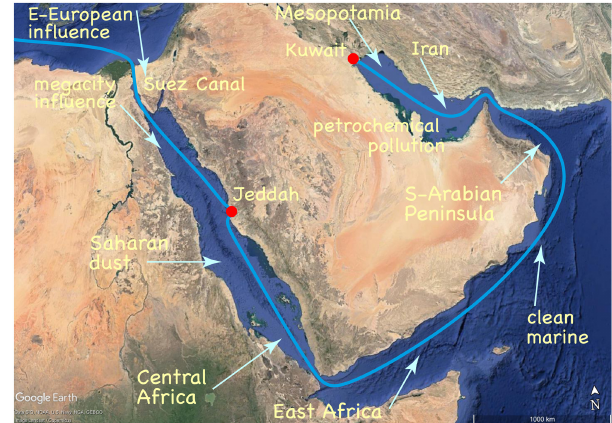
Fig. 1 Ship measurement track of the AQABA campaign. Ship track (two- way, light blue line) from late June to early September 2017. Red circules indicate two stops at Jeddah and Kuwait. The meteorology during summer, characterized by a heat low over the Arabian Peninsula, brings about a wide range of pollution conditions along the track. Prevailing wind directions are indicated by the